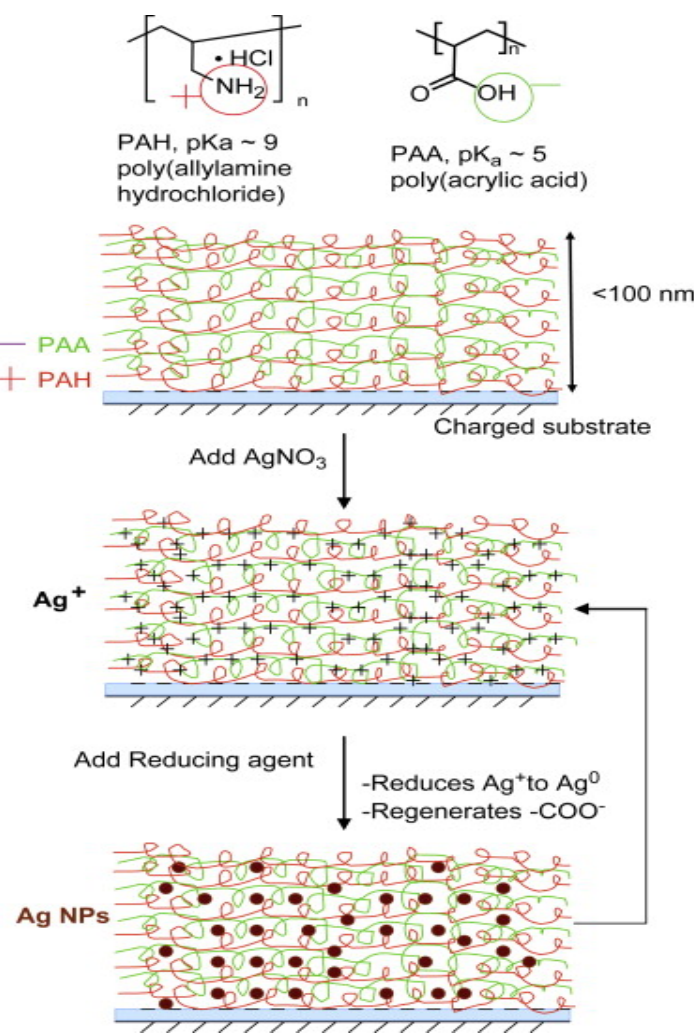
Figure 11. Representation of LbL deposition of multilayers of PAH/PAA on a charged substrate. Post-assembly, the multilayer is incubated with a solution of AgNO 3 . Subsequently, silver ions are reduced to silver nanoparticles. Reproduced from [83], with permission from Elsevier.